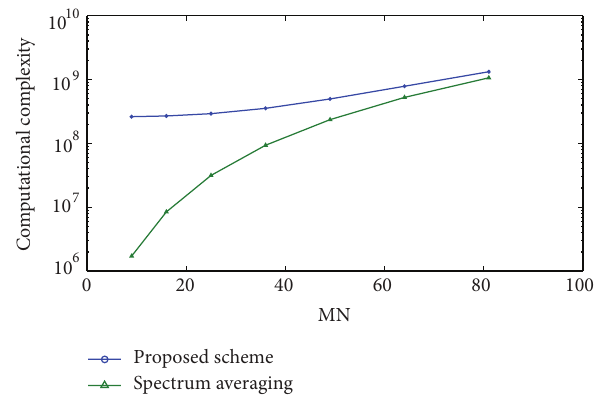
Figure 8: Computational complexity of the proposed scheme against MN antennas ( K = 1000, L =